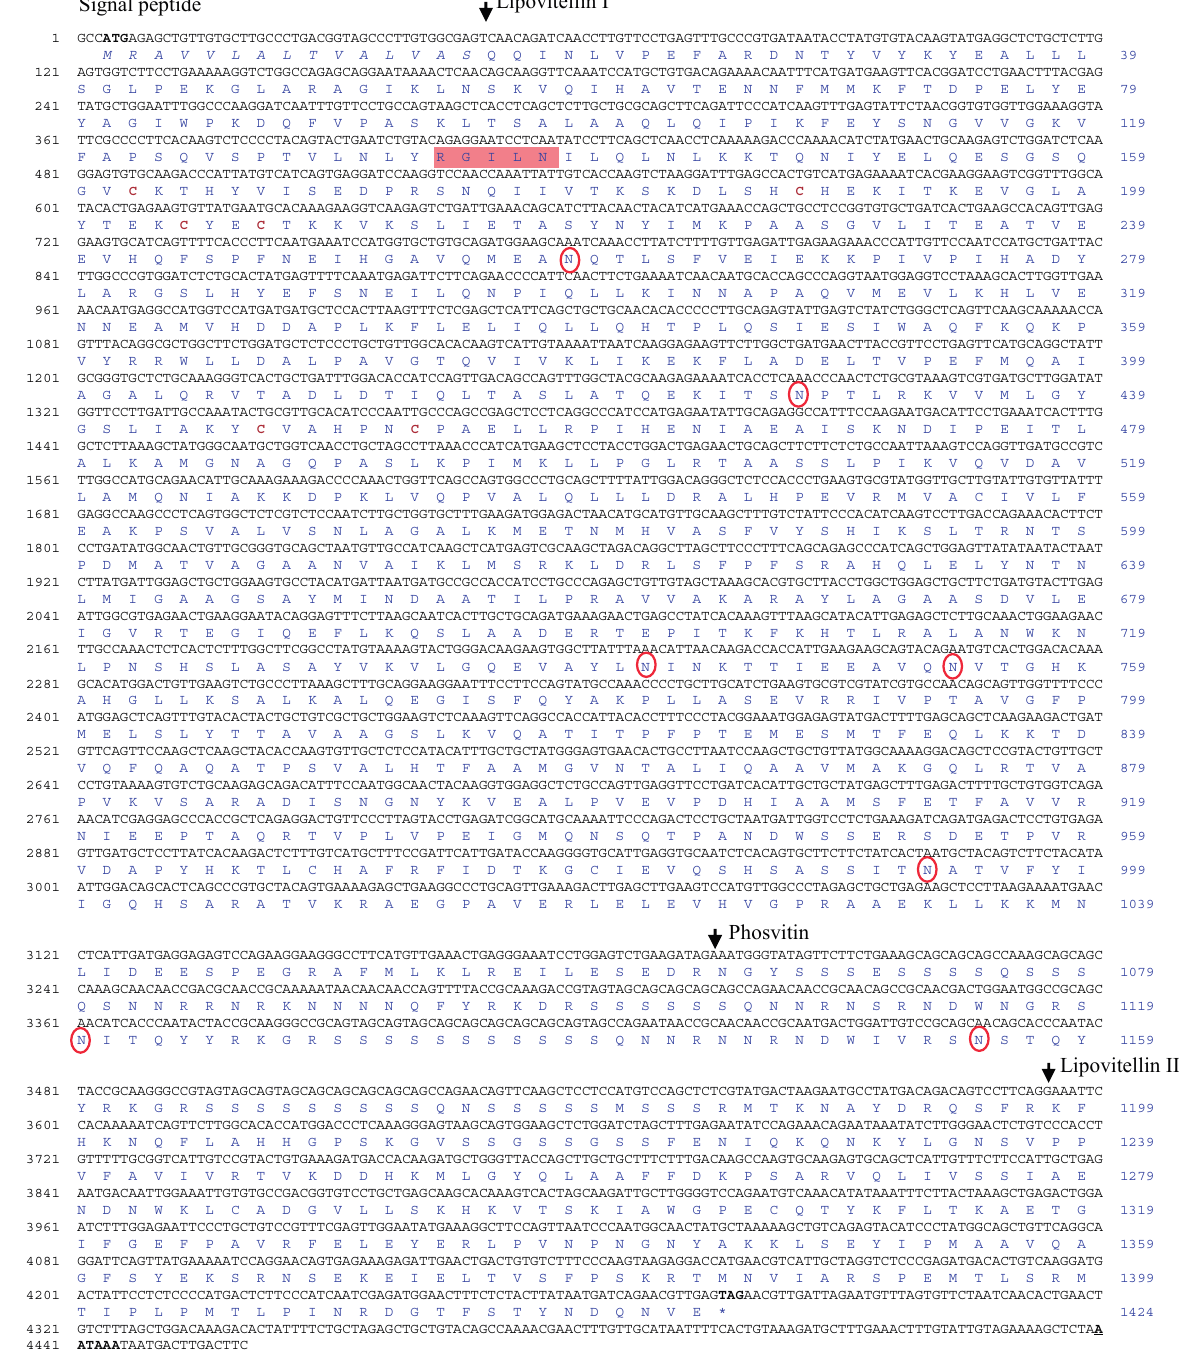
Figure 1. Nucleotide and deduced amino acid sequences of Ru-Vg cDNA. Nucleotides (black) and amino acids (blue) are numbered on the left and right sides of each line, respectively. Start (ATG) and stop (TAA) codons are indicated in bold. Putative signal peptide sequences are shown in italics. The boundaries of the three distinct domains, lipovitellin I, phosvitin, and lipovitellin II, are indicated by arrows. The disulfide bond is indicated in bold and brown, and the N -glycosylation sites are denoted by red rings. The conserved motif (RGILN) of Ru-Vg is in a pink box. Polyadenylation signals (AATAAA) are bold and